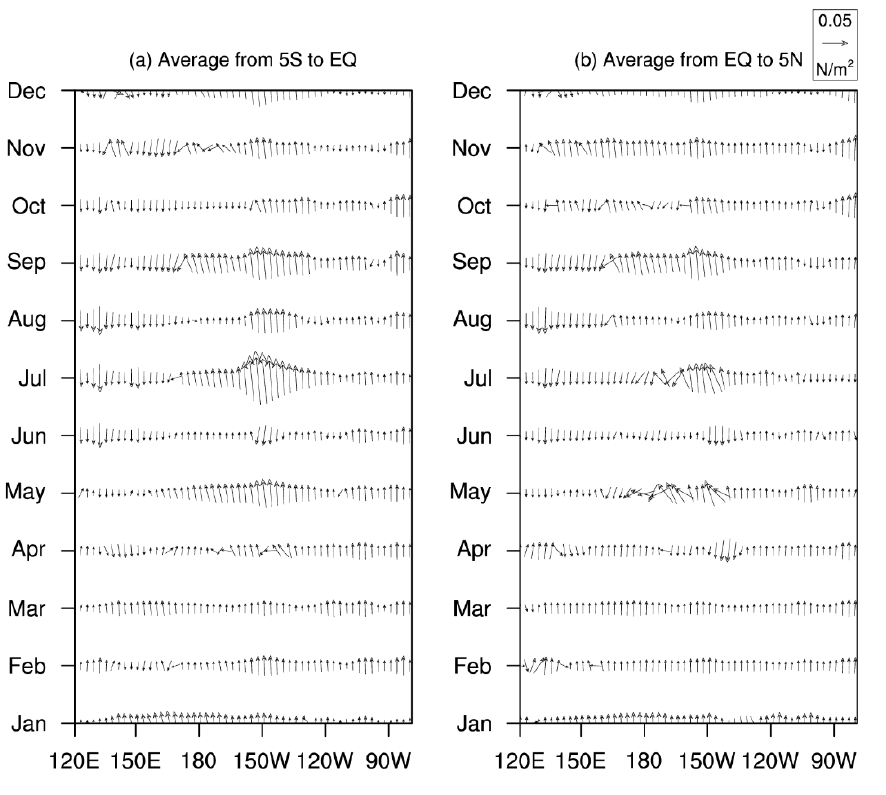
Figure 9. The spatial distribution of the temperature and ocean current anomalies evaluated at the thermocline depth over the central-eastern Pacific (10° S − 10° N, 130° W − 100° W) in the pentad-av- eraged periods of June 2021 ( a,c,e ). The green line marks the equator (left). Zonal-depth sections of the temperature anomalies (the upper 300 m) from (2° N, 123° W) to (7° S, 105° W) in the pentad- averaged area of June 2021 ( b,d,f ). The green and yellow lines mark the thermocline depth and equator, respectively (right). Units: °C for temperature; m s − 1 for currents.